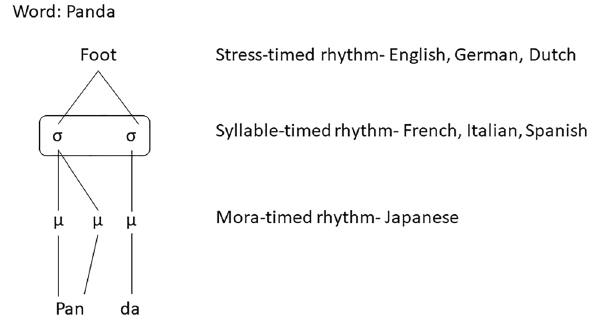
Figure 1. The word ‘Panda’ in terms of its feet (1), syllables (2) and morae